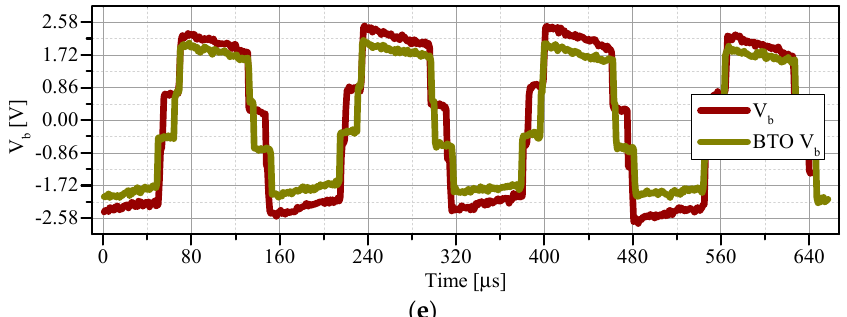
Figure 8. Experimental setup and measuring shaft voltage of the PMSM. ( a ) Rotor without BTO layer. ( b ) Rotor with BTO layer. ( c ) Block diagram of the layout of the experiment. ( d ) Experimental equipment. ( e ) Shaft voltage, V b , of the motor with and without a rotor BTO layer.